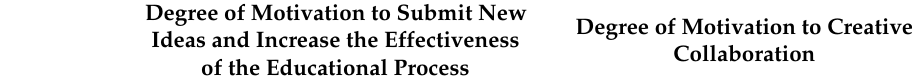
Table 2. Statistical significance of the relationship between selected questions and two aspects of sustainable creativity—teachers’ and students’ perspective (own study).